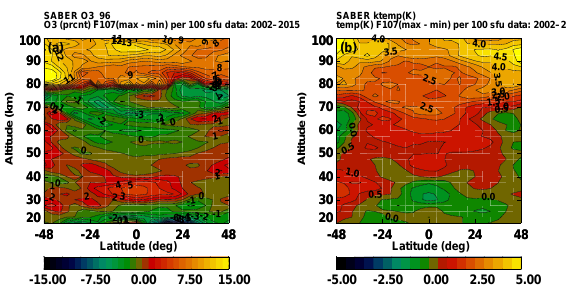
Figure 7. Ozone (left panel, %100sfu − 1 ) and temperature (right panel, K100sfu − 1 ) responses to solar variability on altitude (20– 100km) vs. latitude (48 ◦ S to 48 ◦ N) coordinates, corresponding to responses shown in Fig. 2 but expanded to